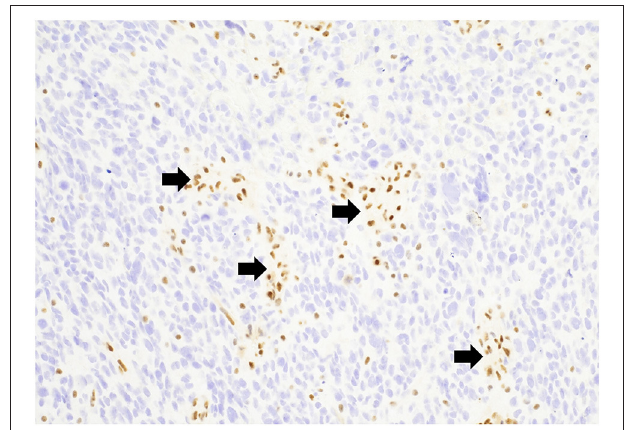
FIGURE 7 | A “glioblastoma” with an ATRX mutation demonstrating a loss of nuclear staining for ATRX with positive endothelial cells serving as an internal control (arrows). ATRX immunostain, 200x magnification.